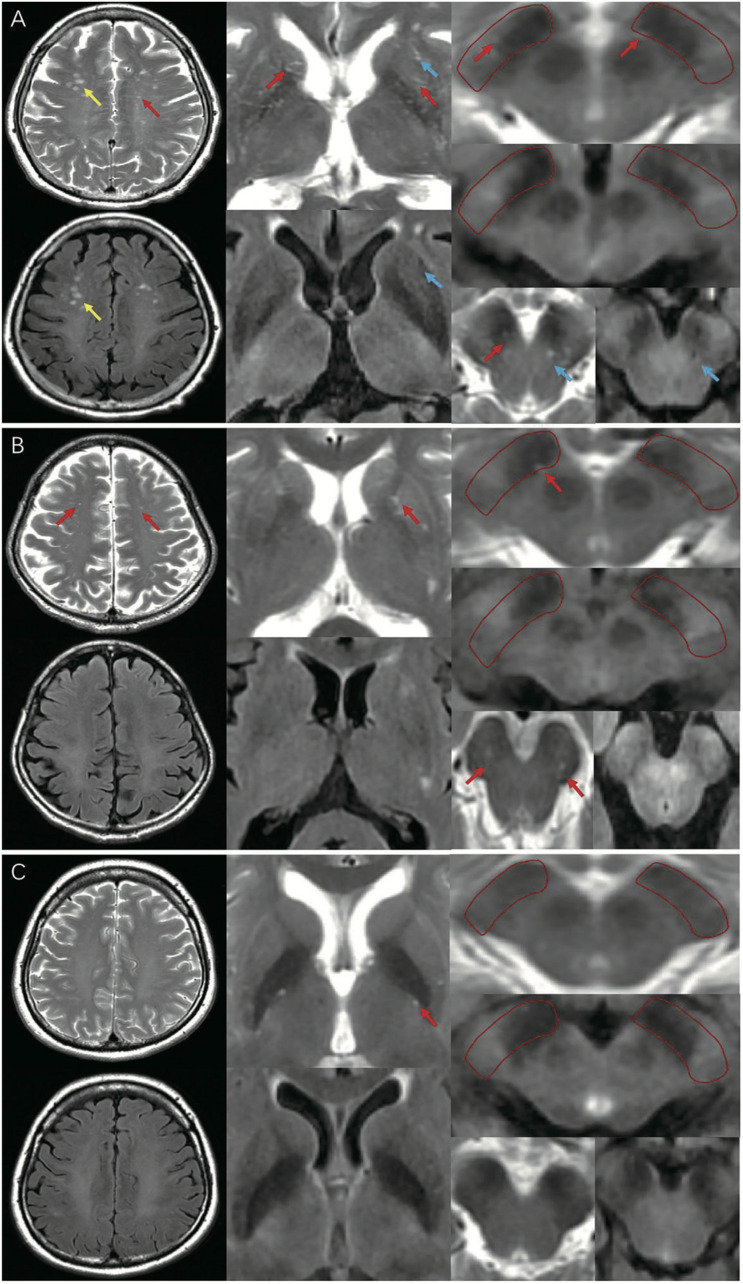
MRI-visible EPVS on T2 and FLAIR imaging. Red arrows indicate EPVS: an EPVS was defined as a fluid-filled space from 1 to 3 mm in diameter with high signal on T2 and low signal on FLAIR imaging, without a perilesional halo. Yellow arrows indicate WMH: a WMH was defined as a lesion with variable size in the white matter, with high signal on both T2 and FLAIR imaging. Blue arrows indicate lacunes: a lacune was defined as a lesion 3–15 mm in diameter with high signal on T2 and a perilesional halo on FLAIR imaging. (A) A representative of EPVS in iRBD group (frequent/severe grade CSO, BG-EPVS, with EPVS in SN and BS); (B) A representative of EPVS in HC group (moderate grade CSO, BG-EPVS, with EPVS in SN and BS); (C) A representative of EPVS in PD group (none/mild grade CSO, BG-EPVS, without EPVS in SN or BS). EPVS, enlarged perivascular spaces; FLAIR: fluid attenuated inversion recovery; WMH, white matter hyperintensity; CSO, centrum semiovale; BG, basal ganglia; SN, substantia nigra; BS, brainstem; MRI, magnetic resonance imaging.